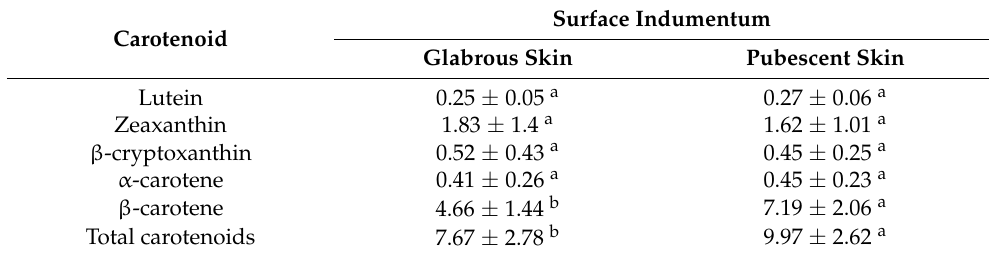
Table 4. Comparison of carotenoid content of yellow-flesh peach with different fruit surface indumenta.